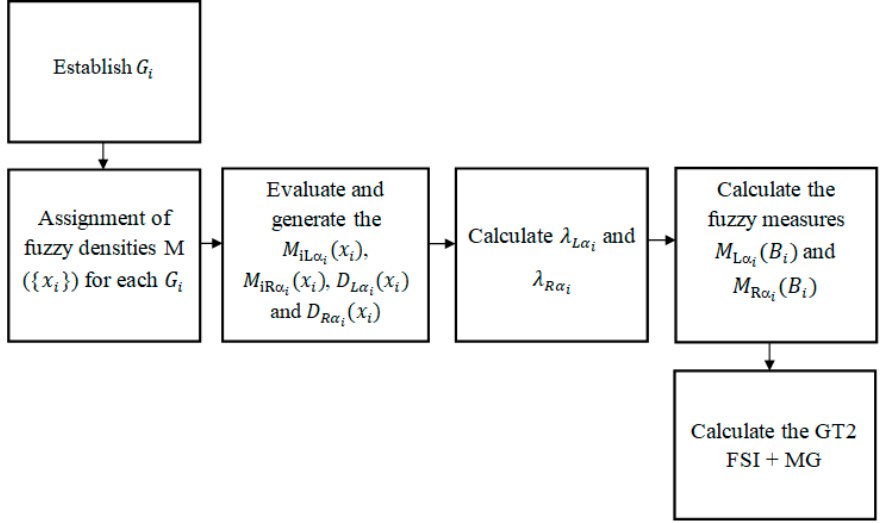
Figure 5. Integration of the image gradients by using GT2 FSI + MG.